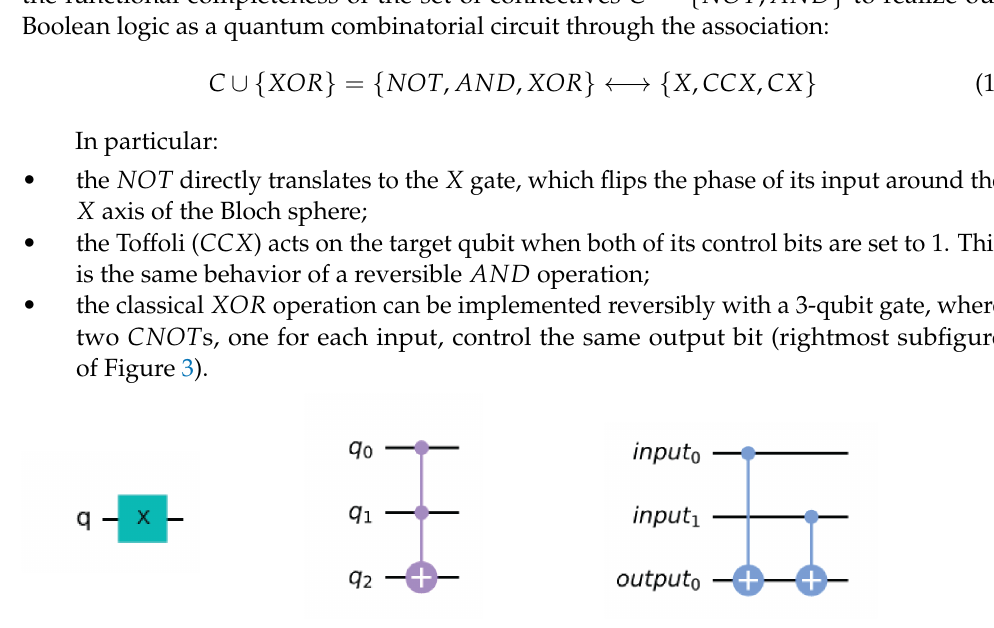
(cid:105) stores | output ⊕ ( input ⊕ input ) (cid:105) . In the last two 0 0 0 1 · q (cid:105) and 0 1